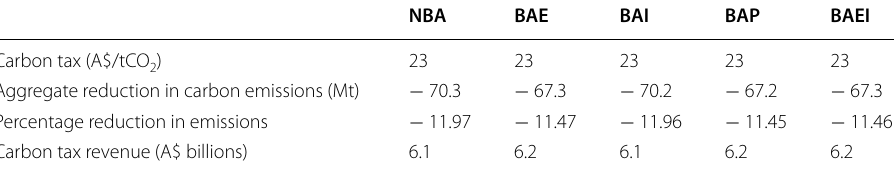
Table 4 Selected projections on environmental variables. Source Model simulations NBA BAE BAI BAP BAEI Carbon tax (A$/tCO 2 )